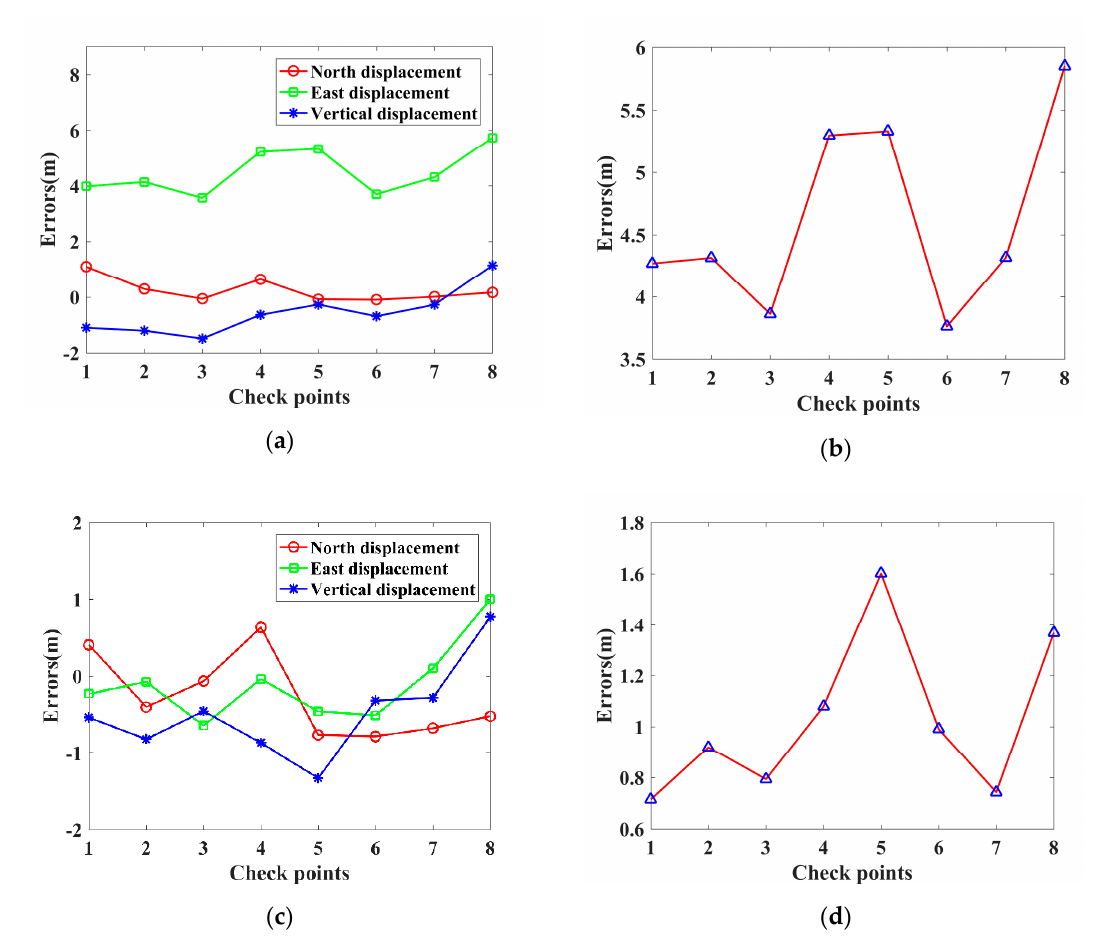
Figure 8. The geolocation errors for the Banshan Pavilion at Western Hills in Beijing with two methods. ( a , c ) are the geolocation errors in the north, east and vertical displacements for M1 and M2, respectively. ( b , d ) are the three-dimensional errors for M1 and M2, respectively.